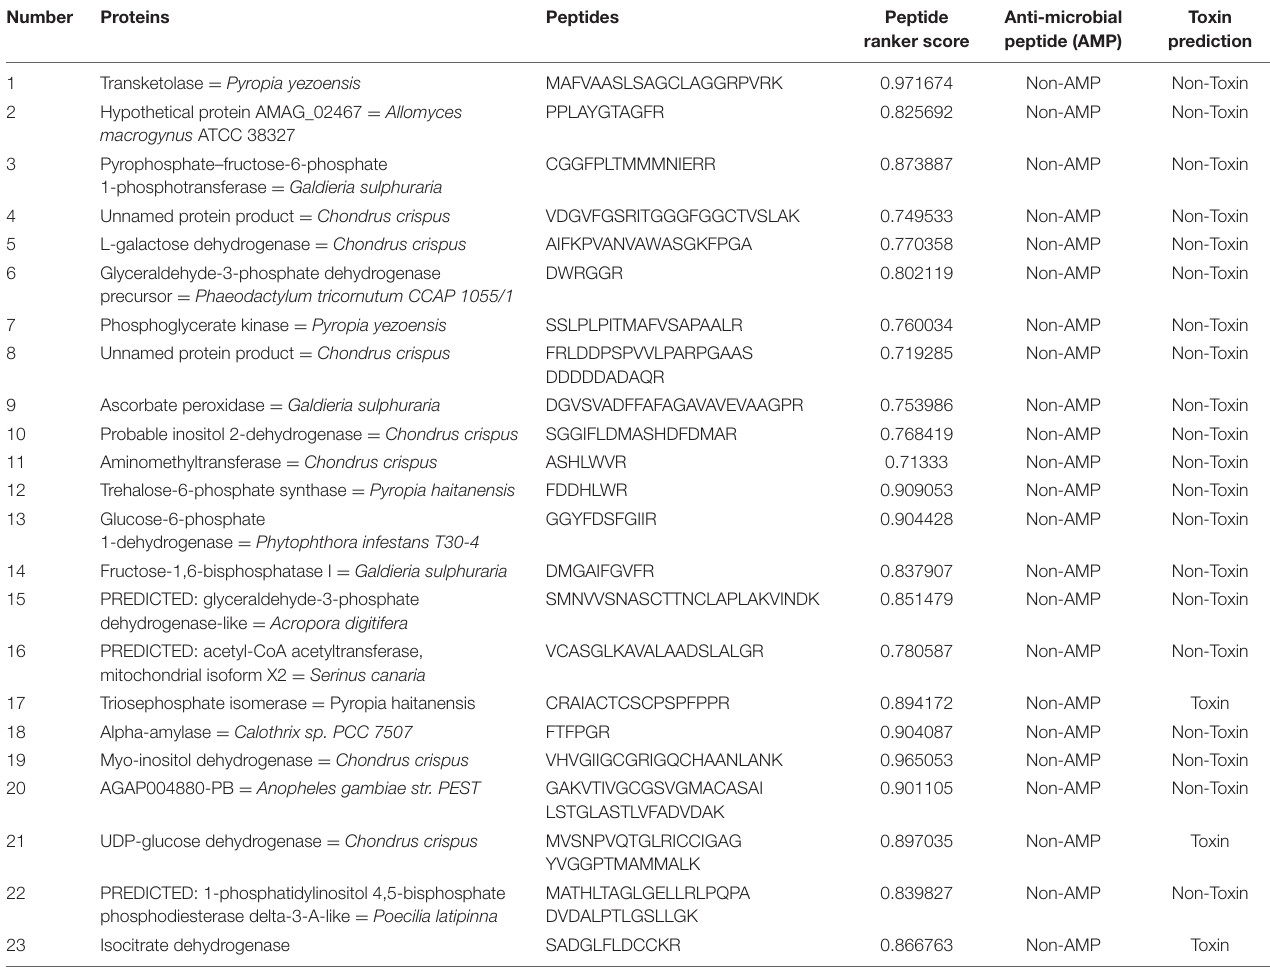
TABLE 6 | Selected potential bioactive peptides of the carbohydrate metabolism proteome predicted by in silico digestions with trypsin. Number Proteins Peptides Peptide